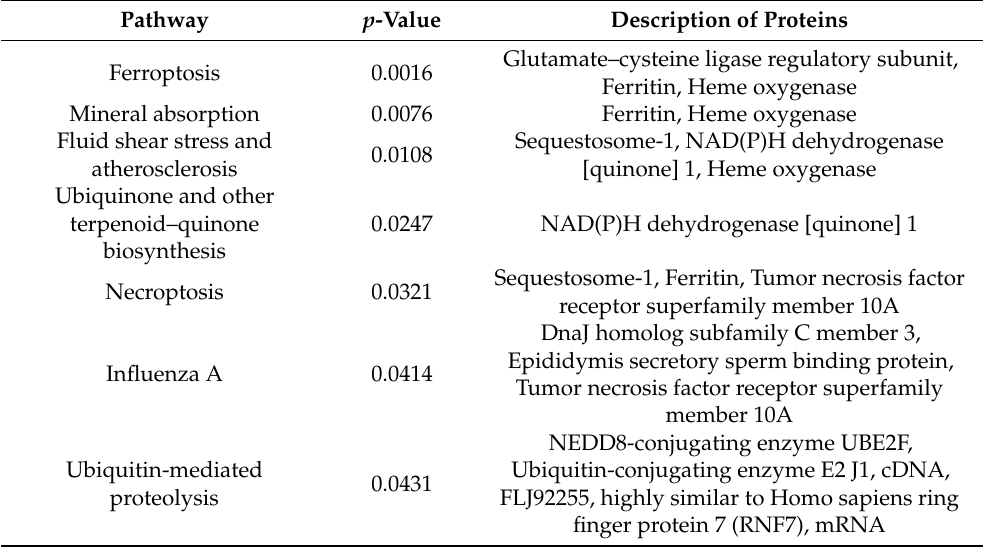
Table 1. These differential proteins in different pathways.